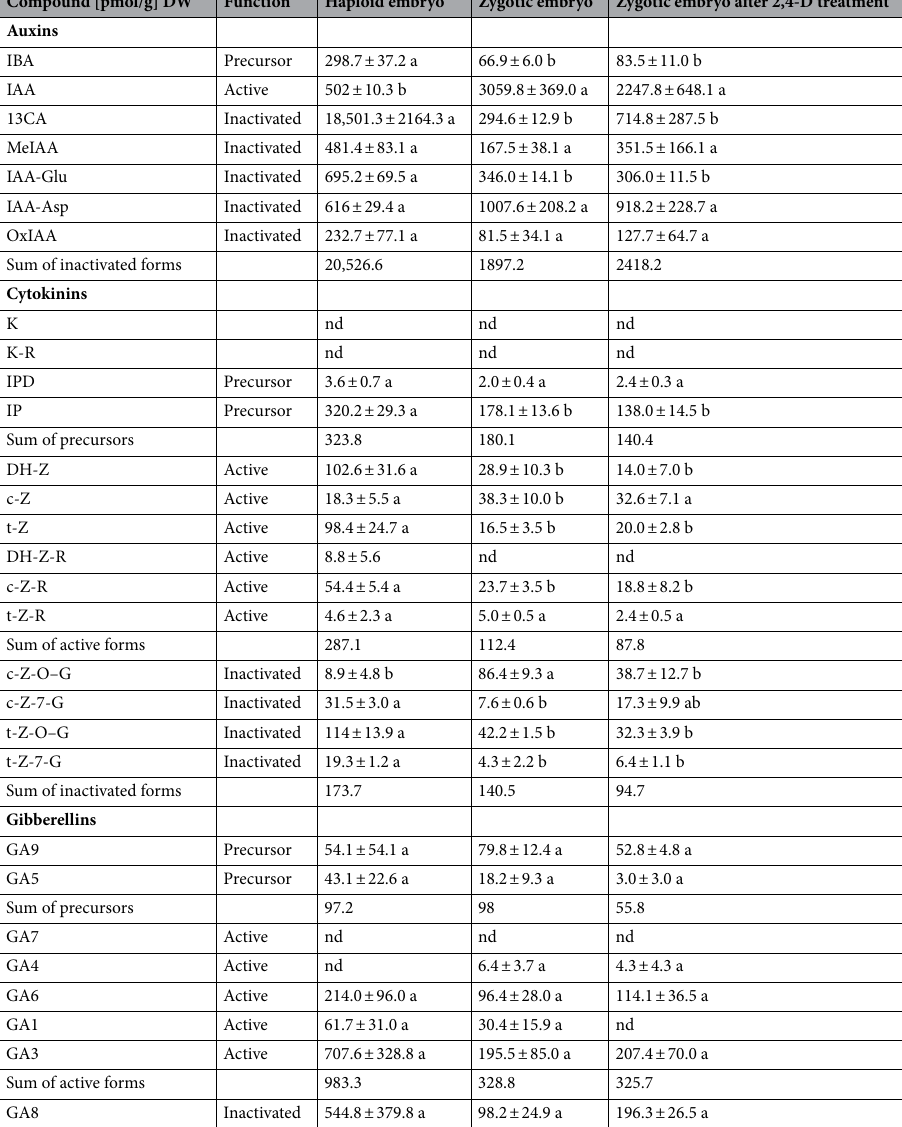
post hoc Duncan’s